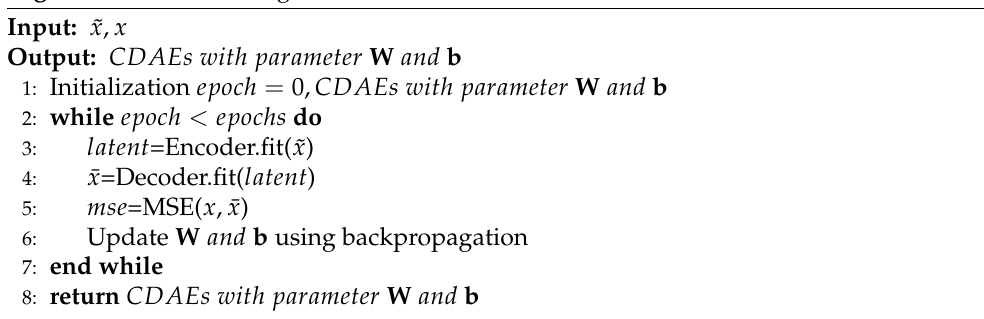
Algorithm 1 The Training Process for